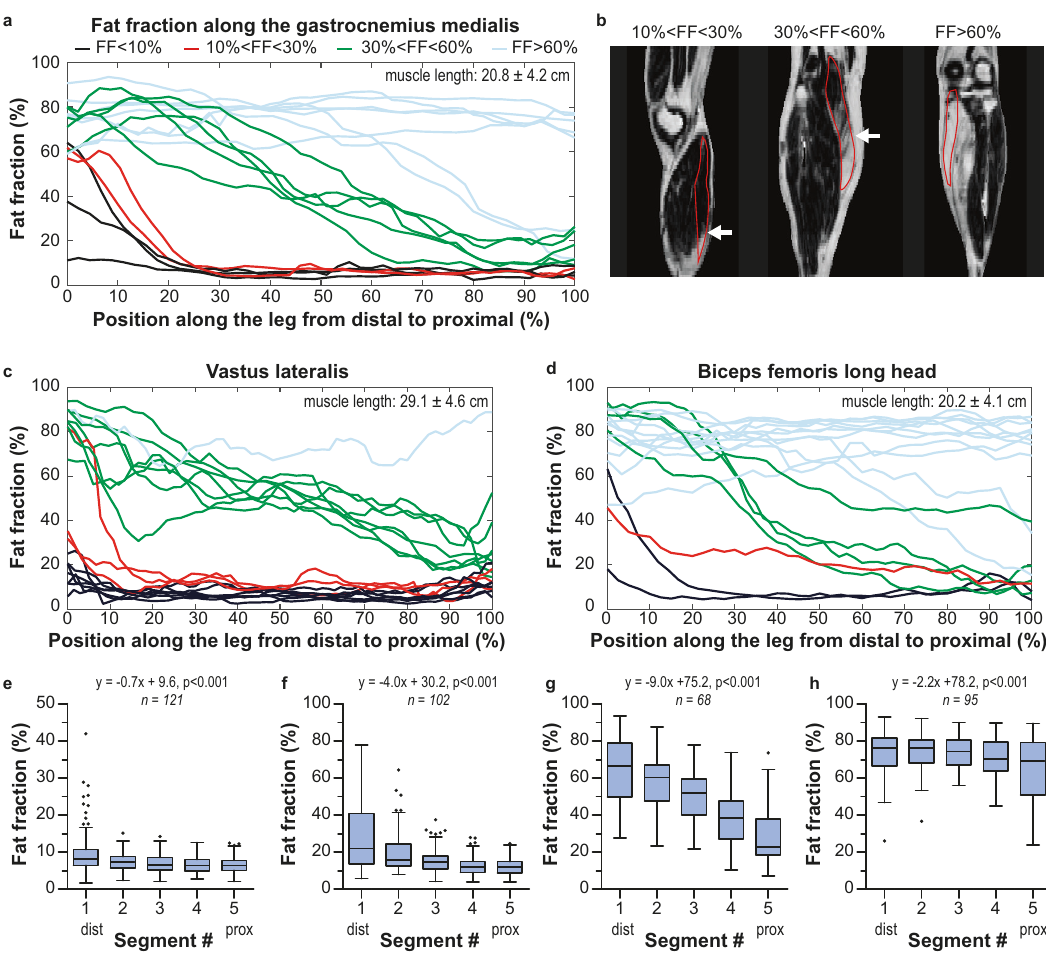
Fig. 2 Quantitative evaluation of fat fractions along the muscle length in facioscapulohumeral muscular dystrophy (FSHD) patients. a Fat fraction displayed at each position along the gastrocnemius medialis expressed as a percentage of muscle length from the most distal segmented slice (0%) to the most proximal segmented slice (100%). Muscles from all participants were divided into four groups: fat fraction <10% (black), 10 – 30% (red), 30 – 60% (green), and >60% (light blue). b Dixon fat fraction maps showing typical examples of fat in fi ltration in the gastrocnemius medialis (delineated in red). Left: sagittal view of the right lower leg of a 52-year-old male showing fat in fi ltration at the distal muscle end (white arrow depicts fat front). Middle: coronal view of the right lower leg of a 67-year-old female. The distal half of the gastrocnemius is fully in fi ltrated with fat, while the proximal half shows almost no fat in fi ltration (the white arrow depicts the fat front). Right: coronal view of the right lower leg of a 69-year-old male exhibiting a fully fat- in fi ltrated gastrocnemius medialis. c , d As fi gure a , but now for two upper leg muscles, vastus lateralis ( c ) and biceps femoris long head ( d ). e – h Tukey boxplots (showing median, interquartile range, and outliers) of fat fractions in fi ve segments (distal-to-proximal) along the muscle with the corresponding linear mixed model fi t for muscles with baseline fat fraction <10% ( d ), 10 – 30% ( e ), 30 – 60% ( f ), and >60% ( g ); n is the number of included